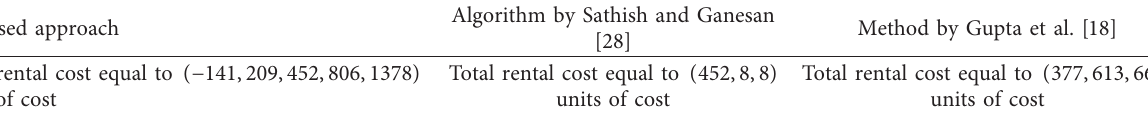
Table 5: Comparison of the example results. Algorithm by Sathish and